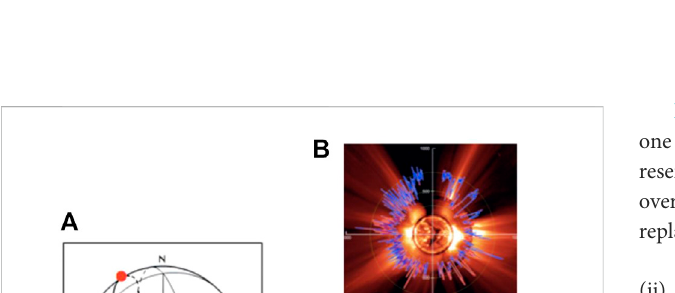
Frontiers in Astronomy and Space